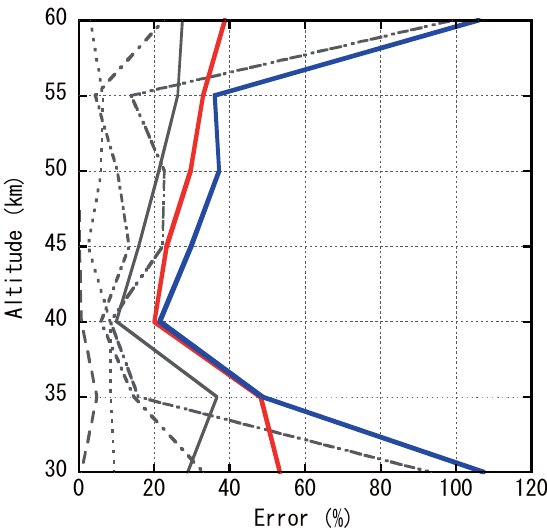
Fig. 6. Estimated random errors due to temperature profile (dash), a priori profile (day: dash-dot, night: dash-dot-dot), random noise on the spectrum (solid), and atmospheric correction (dot). Total of the random errors (i.e., root sum square of the individual errors) are indicated by colored solid lines (red for daytime and blue for